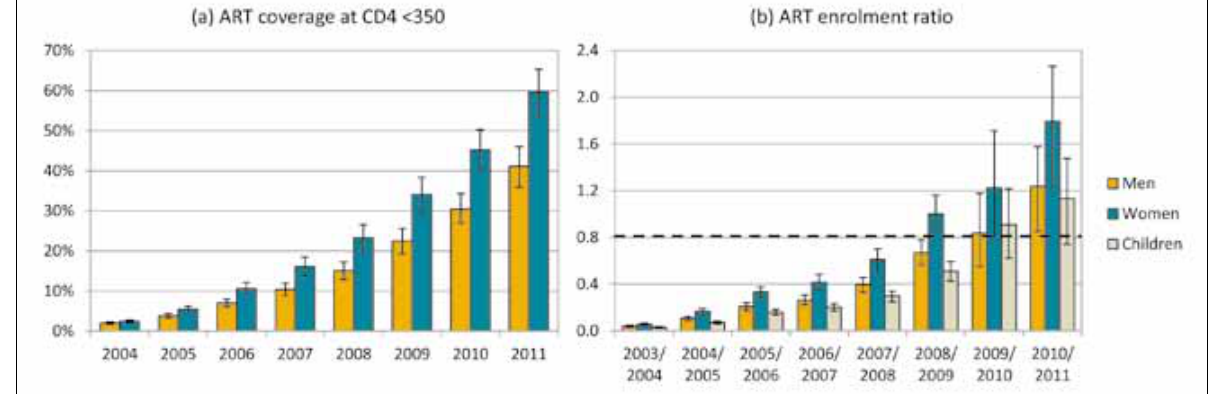
Fig. 4. Age and sex differences in ART access. Bars represent posterior means and error bars represent 95% confidence intervals. Dashed line in panel (b) represents 2007 - 2011 National Strategic Plan